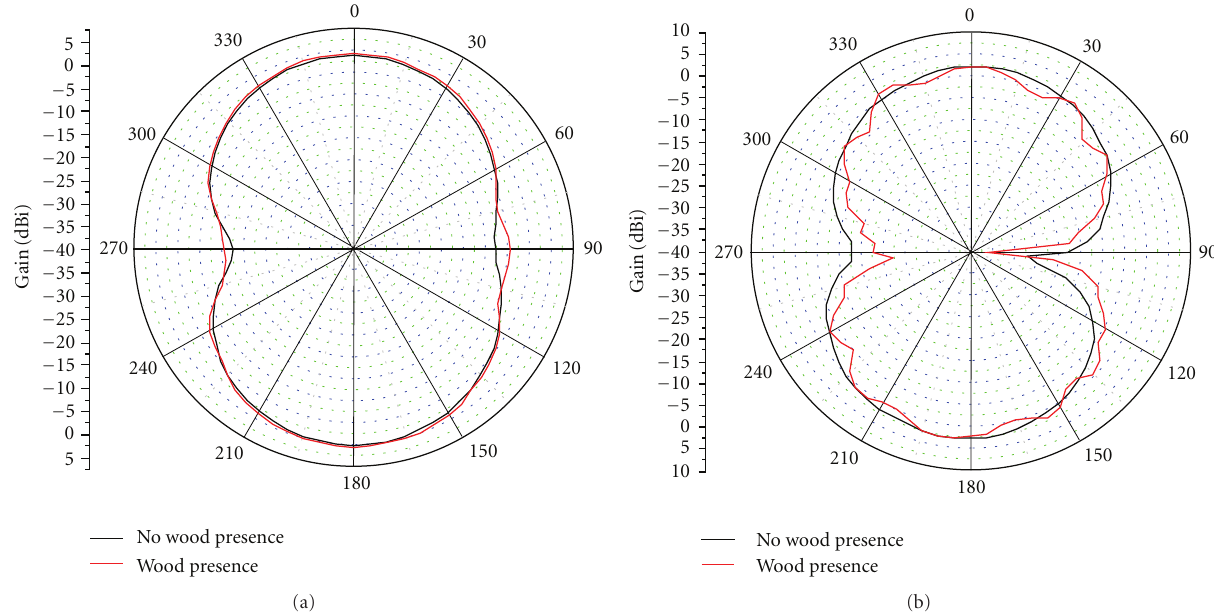
Figure 23: Radiation pattern of dipole with and without wooden base in E-plane: (a) simulated and (b) measured.